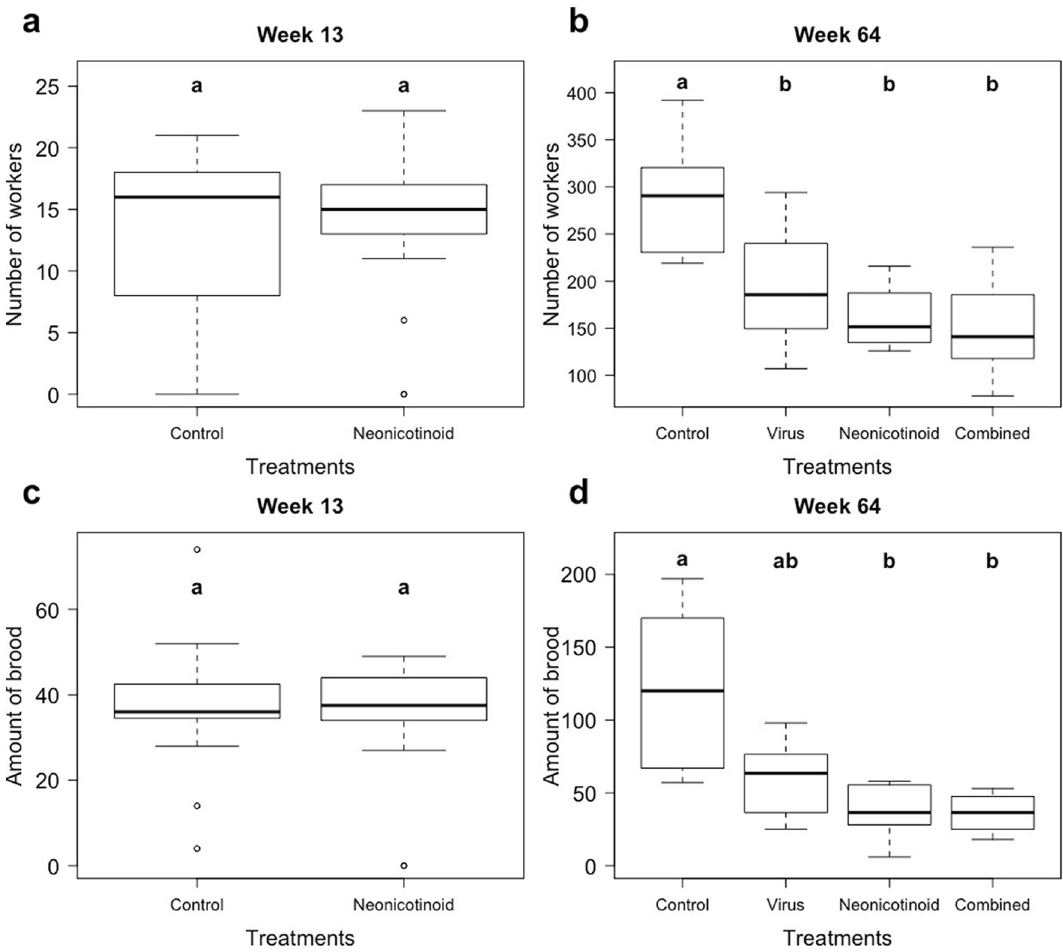
Figure 2. Colony strength. The number of Lasius niger workers ( a , b ) and the amount of brood (sum of eggs, larva and pupae; c , d ) before the first overwintering (week 13, a , c ) and the end of the experiment (week 64, b , d ). At the first overwintering only the neonicotinoid treatment (chronic exposure to 30 ppb thiamethoxam) was established (controls N = 19, neonicotinoid N = 18). Colonies were then split in a stratified random way to two more treatment groups (each N = 8; virus = feeding regime with Acute bee paralysis virus (ABPV) & combined = exposure to thiamethoxam and ABPV. The inter-quartile-ranges, medians and outliers of boxplots are shown with significant differences (Kruskal Test ( a , c ), Tukey post hoc test (b&d); p < 0.05) between treatments being indicated by bold exposure. However, in contrast to our expectations, the behaviour of individuals was not affected by exposure to thiamethoxam. Moreover, no interactive effects of combined exposure were observed. In comparison, effects of neonicotinoid insecticide exposure on honey bee activity and locomotion have been shown, including longer inactivity, lower movement, and hyperactivity followed by hypoactivity 66,72 . Many aspects like foraging and competition (intra- and interspecific) are restricted by impaired locomotor abilities. For example, a reduced movement speed increases the time required to exploit available resources, which in turn can affect the colony growth rate 73 . A reduced work force impairs colony functioning, reduces competitive strength and decreases the number of produced sexuals 74–77 . Therefore, it is possible that the effects of virus exposure on locomotion can result in a reduction of colony performance and ultimately fitness (i.e. number of produced males and gynes that successfully contribute to the foundation of new colonies). To determine possible caste specific differences in susceptibility towards ABPV, we used virus titres as an indication of infection levels. When normalized to body mass, there were no differences regarding the virus load of queens and workers. Despite the detection of clinical symptoms (i.e. impaired locomotion) the observed virus titres did not reach the levels of overt infections in honey bees 78 . However, there was one exception, as the workers found dead in one colony towards the end of the experiment reached more than 10 7 copies per mg tissue. Why titres were higher in these specimens and why worker mortality was induced in this particular colony, but not in others, remains speculative. Our results suggest that ABPV infections can be lethal in L. niger , in addition to symptoms reported earlier 58 . A comparison of honey bees and ants is meaningful in this regard because these viruses have been studied in depth in the former 48 , but not in the latter. Both ants and honey bees are highly eusocial with reproductive division of labour, overlapping generations and cooperative brood care and